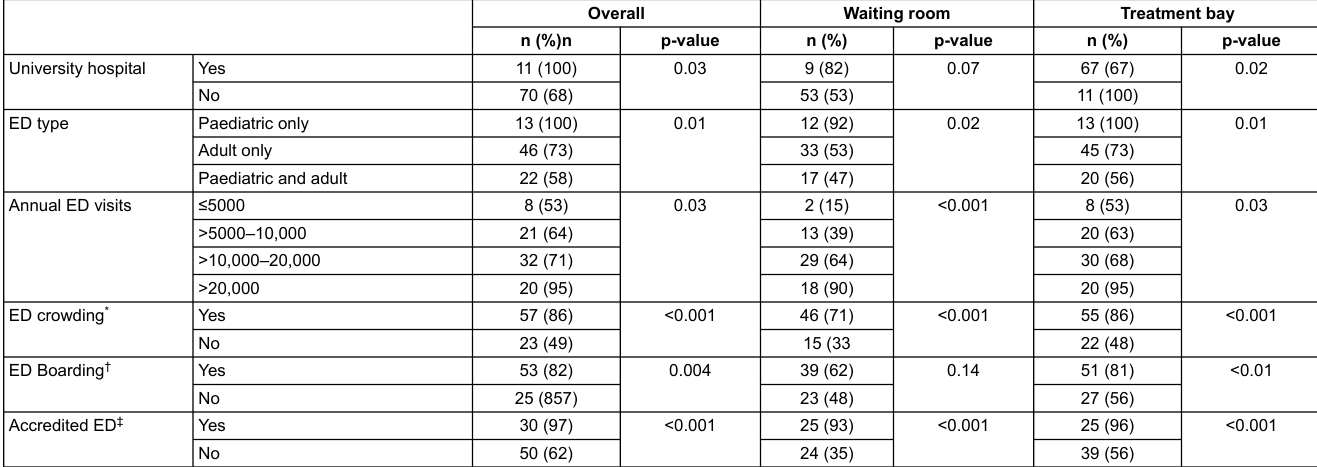
Table 2: Nurse-initiated protocol pain intensity emergency department (ED)